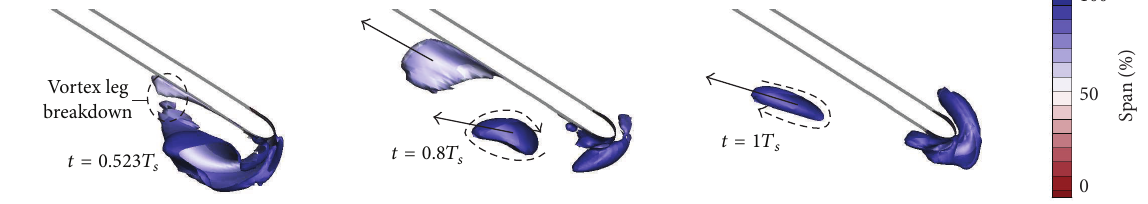
Figure 15: Instantaneous isosurface of the negative 𝜆 2 vortex criterion representing the vortex